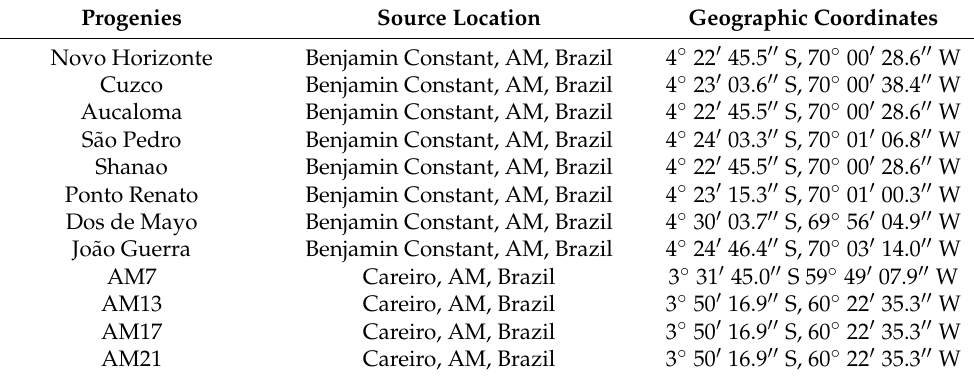
Table 1. Description of the Plukenetia volubilis progenies’ names in the study, source location, and geographic